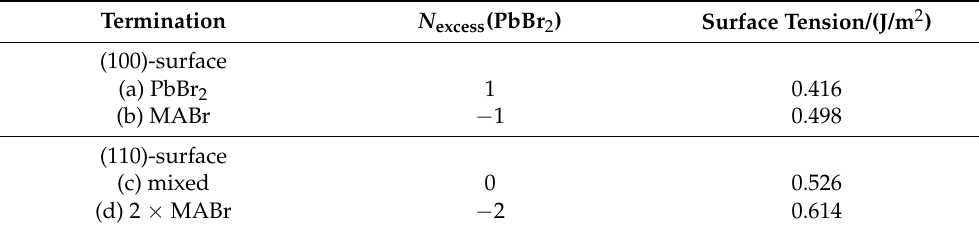
Table 1. Summary of the surface tensions of the ab-initio calculated structures with (100)- and (110)-surfaces. Slabs with seven unit cells were studied with the four different surface terminations shown in Figure 7. All values are given in J/m 2 . N excess ( PbBr 2 ) values used in Equation (3) are given to mark the excess of PbBr 2 in the surface